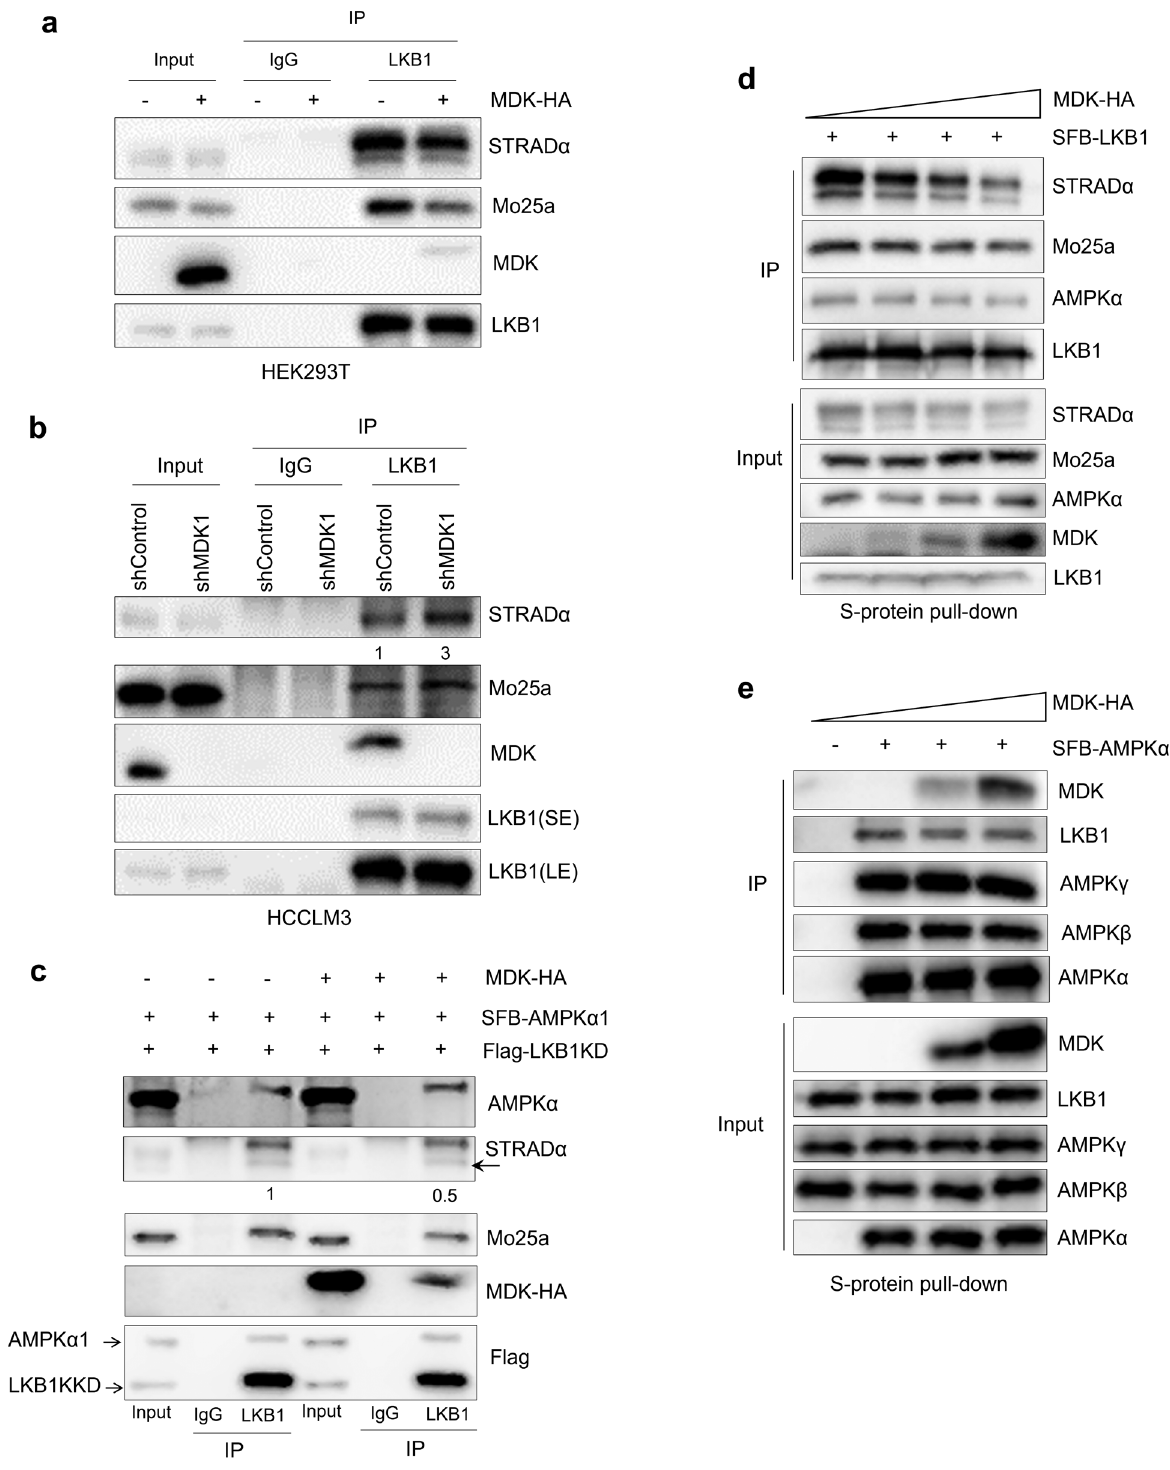
Fig. 4 Midkine depolymerized LKB1-STRAD-Mo25 complex. a – b LKB1 was immunoprecipitated from the HEK293T cells transduced with MDK-HA ( a ) and the HCCLM3 cells transduced with MDK shRNA1 ( b ), and then, Western blot analysis was performed with antibodies against STRAD α , Mo25a, MDK and LKB1. c LKB1 was immunoprecipitated from the HEK293T cells transduced with MDK-HA and the control cells followed by Western blotting with antibodies against AMPK α , STRAD α , Mo25a, HA, and FLAG. The indicated constructs were expressed in the HEK293T cells for 48 h, and the cell lysates were subjected to coimmunoprecipitation with primary LKB1 and IgG antibodies. d – e HEK293T cells were cotransfected with different doses of MDK-HA and SFB-tagged LKB1 ( d ) or SFB-tagged AMPK α 1 ( e ), pulled down with S protein beads, and subjected to Western blot analysis with antibodies against STRAD α , Mo25a, LKB1, MDK and AMPK subunits.